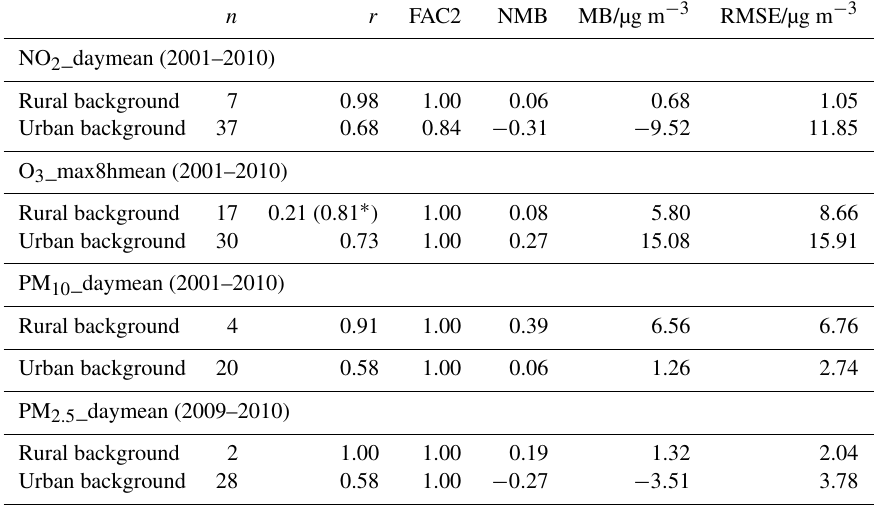
Table 1. Numbers of UK AURN (Automatic Urban and Rural Network) sites satisfying the data capture criteria described in Sect. 2.2, together with model–measurement statistics (as defined in Sect. 2.4) for the 10-year means of NO 2 _daymean, O 3 _max8hmean, and PM 10 _daymean, and for the 2-year means of PM 2 . 5 _daymean. The latter data provide a measure of the spatial agreement between modelled and measured pollutant concentrations across the